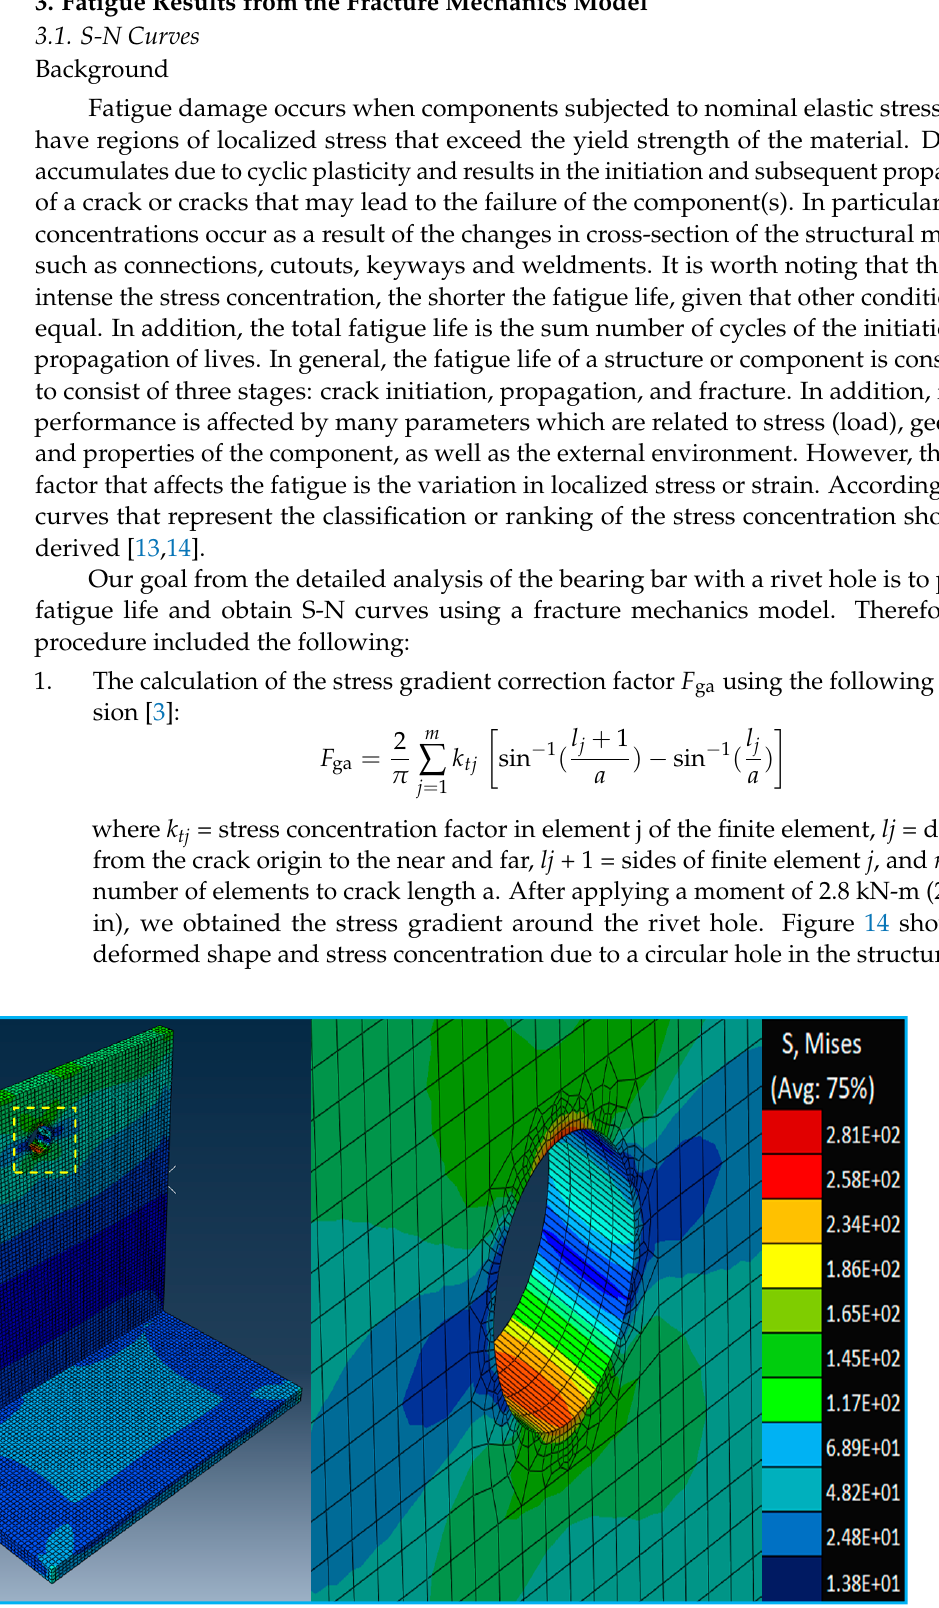
Figure 14. Stress concentration around the hole in the negative moment region [15].